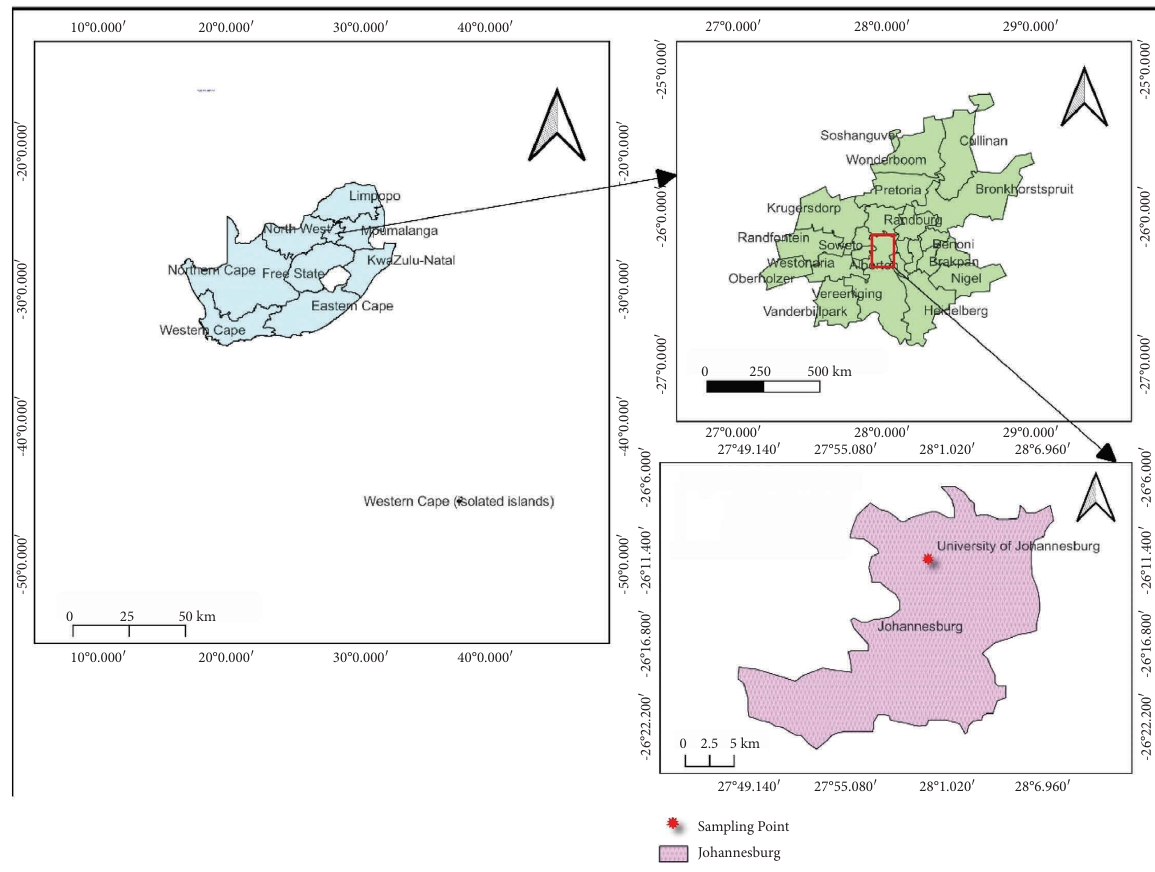
Figure 1: Map showing the geographic location of the study techniques, such as FCM, subtractive clustering (SC), and GP. Due to the fact that clustering approaches have a sub- stantial impact on the precision of the model when ap- proximating an output function, the choice of clustering approaches must be made carefully [54]. In addition to its speed-boosting capability, the FCM ofers the advantage that it does not restrict cluster boundaries, which allows objects to belong to more than one group rather than to a single group exclusively [55]. Te expression in equation (8) is utilized to minimize the distance center to each datum for Figure 2: Architectural design of the hybrid model. each fuzzy group n and vector x i , i � 1, 2, . . . n